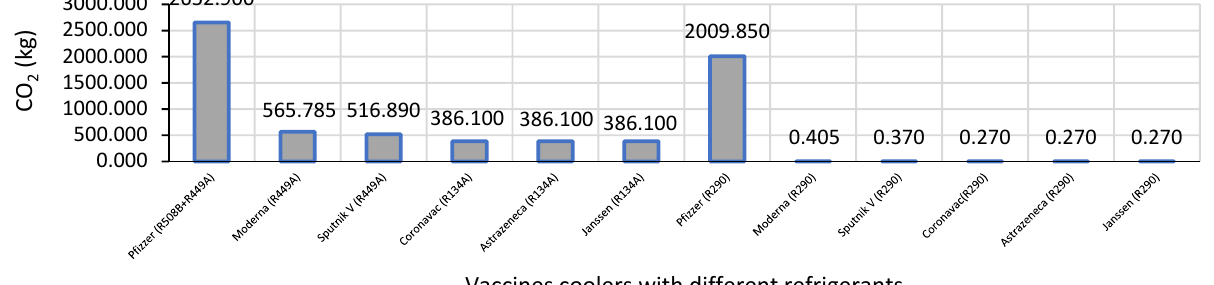
Figure 1. Environmental impact (equivalent CO 2 emissions) for different vaccines’ refrigeration sys- tems.